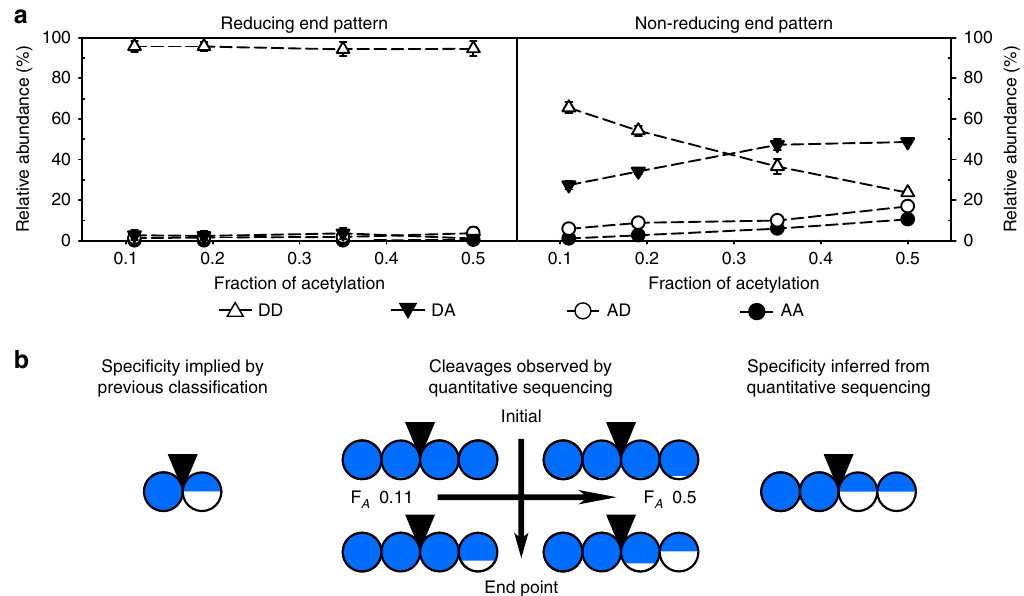
Fig. 5 Speci fi city of the representative class III chitosanase CSN-MHKI inferred from its products. ( a ) The patterns of acetylation of the two terminal sugar units were analyzed for different F A of the substrates by quantitative sequencing of the products at the endpoint of enzymatic hydrolysis. The molar fractions (mean values of at least three independent measurements of three independent enzyme batches) of all possible diads (DD, DA, AD, and AA) are shown. ( b ) The speci fi city of class III chitosanases implicated by the established qualitative classi fi cation system compared to the speci fi city of CSN-MHKI (a model class III chitosanase) inferred from the cleavages observed by quantitative sequencing of its products ’ sugar moieties. Diad frequencies at the early time points of enzymatic hydrolysis are taken from Supplementary Table 5. Detailed oligomer compositions are shown in Supplementary Table 4. The circles are divided according to the percentage of the relative abundances (molar fractions) of GlcN (blue) and GlcNAc (white) at the two corresponding subsites, left, ( − 2) and ( − 1), and right, (+1) and (+2), of the catalytic cleavage site (indicated by a black inverted triangle). The mean values with standard deviations of at least three independent measurements of three independent enzyme batches are shown (Supplementary Tables 4 and